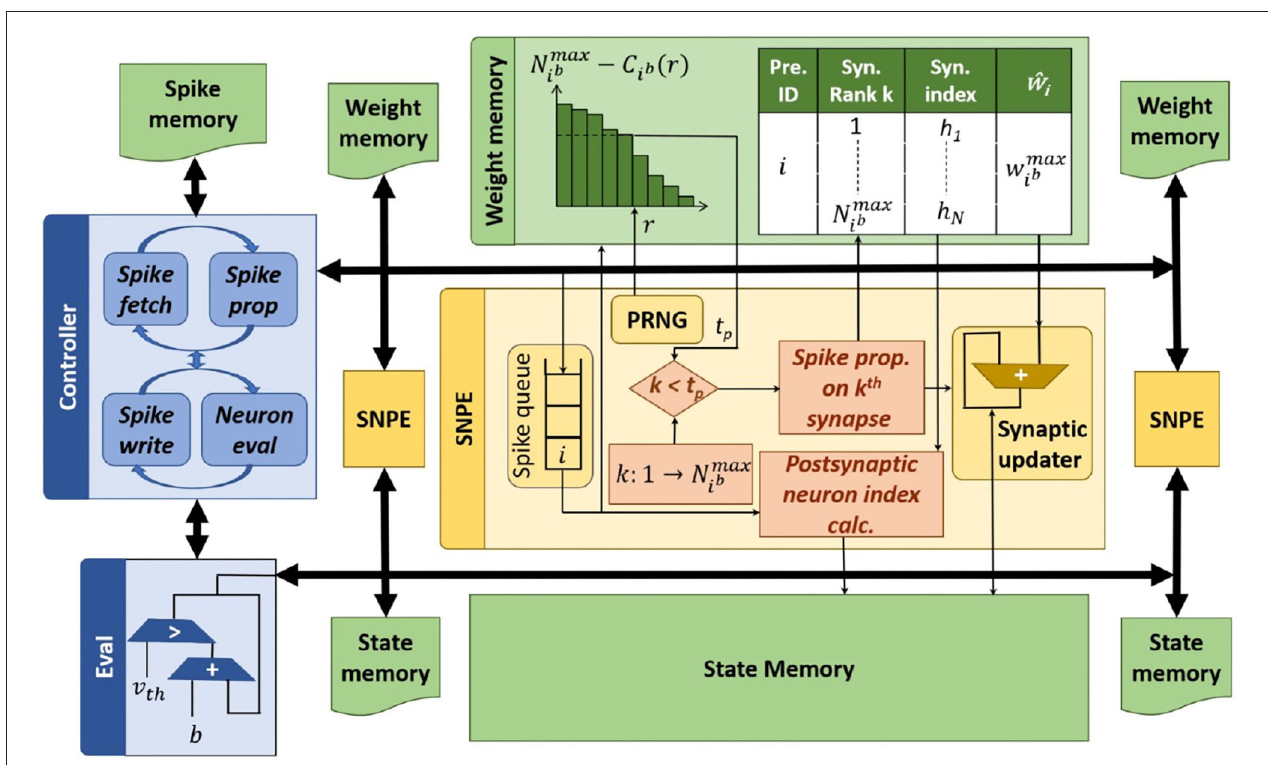
FIGURE 8 | P-SNNAP accelerator